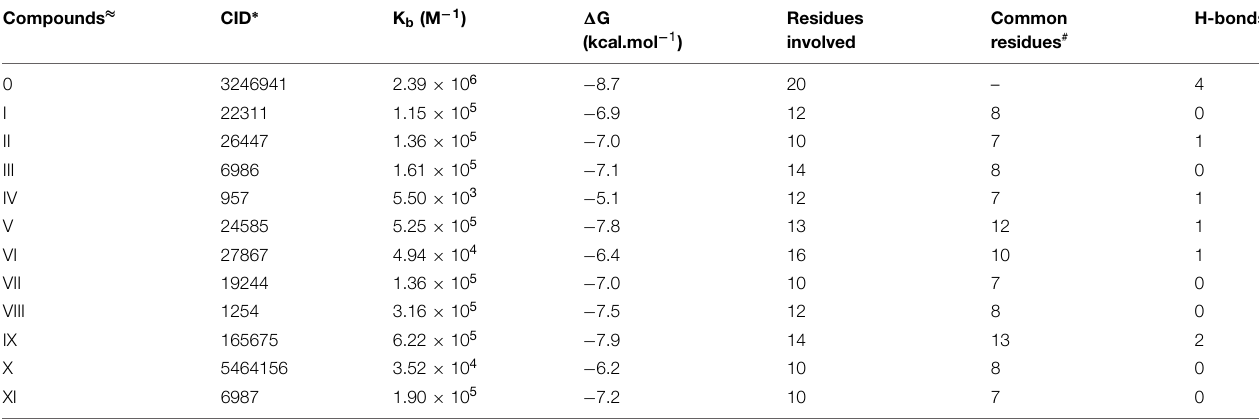
TABLE 3 | Molecular docking results of LasR-inhibitor interactions. Compounds ≈